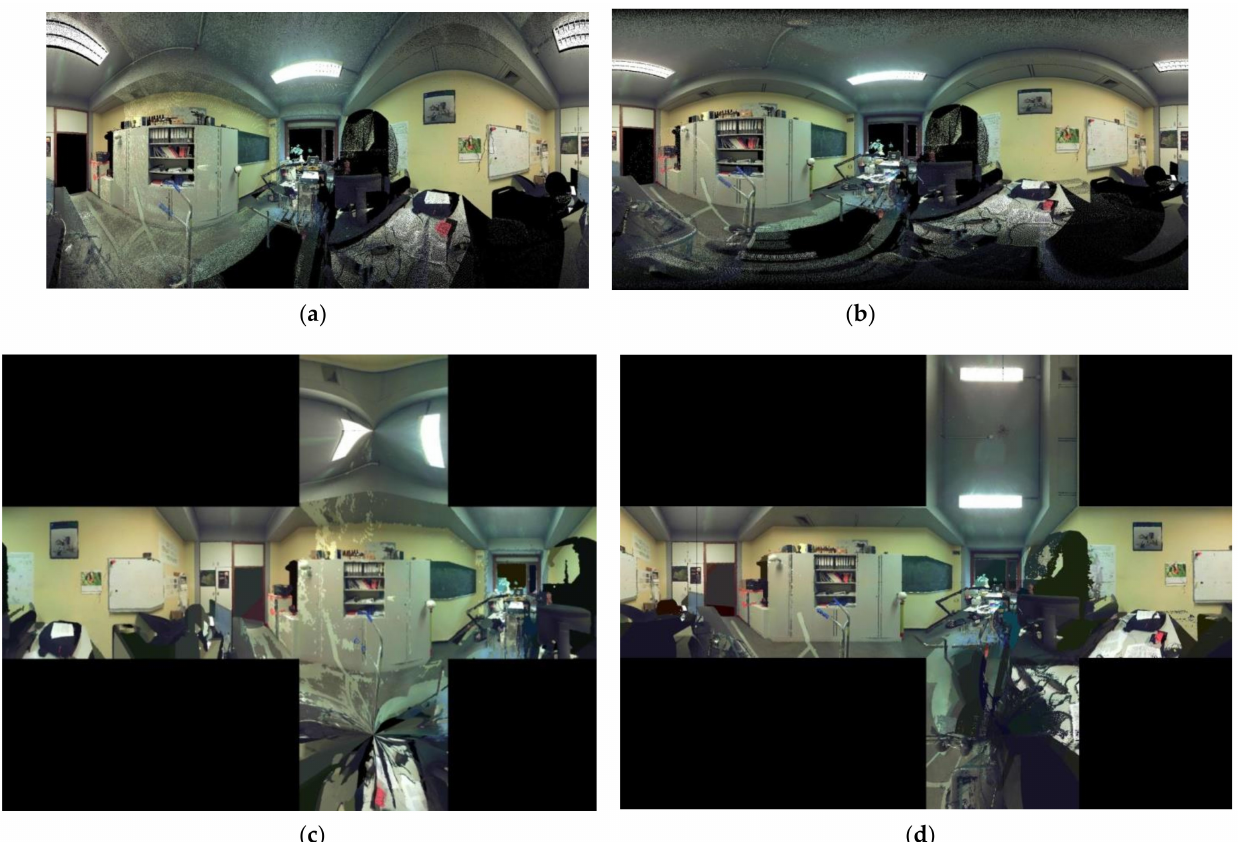
Figure 30. Generation of panoramic images, Tabkha’s approach on the left and the current approach on the right: ( a , b ) 360 ◦ panoramic image; ( c , d )